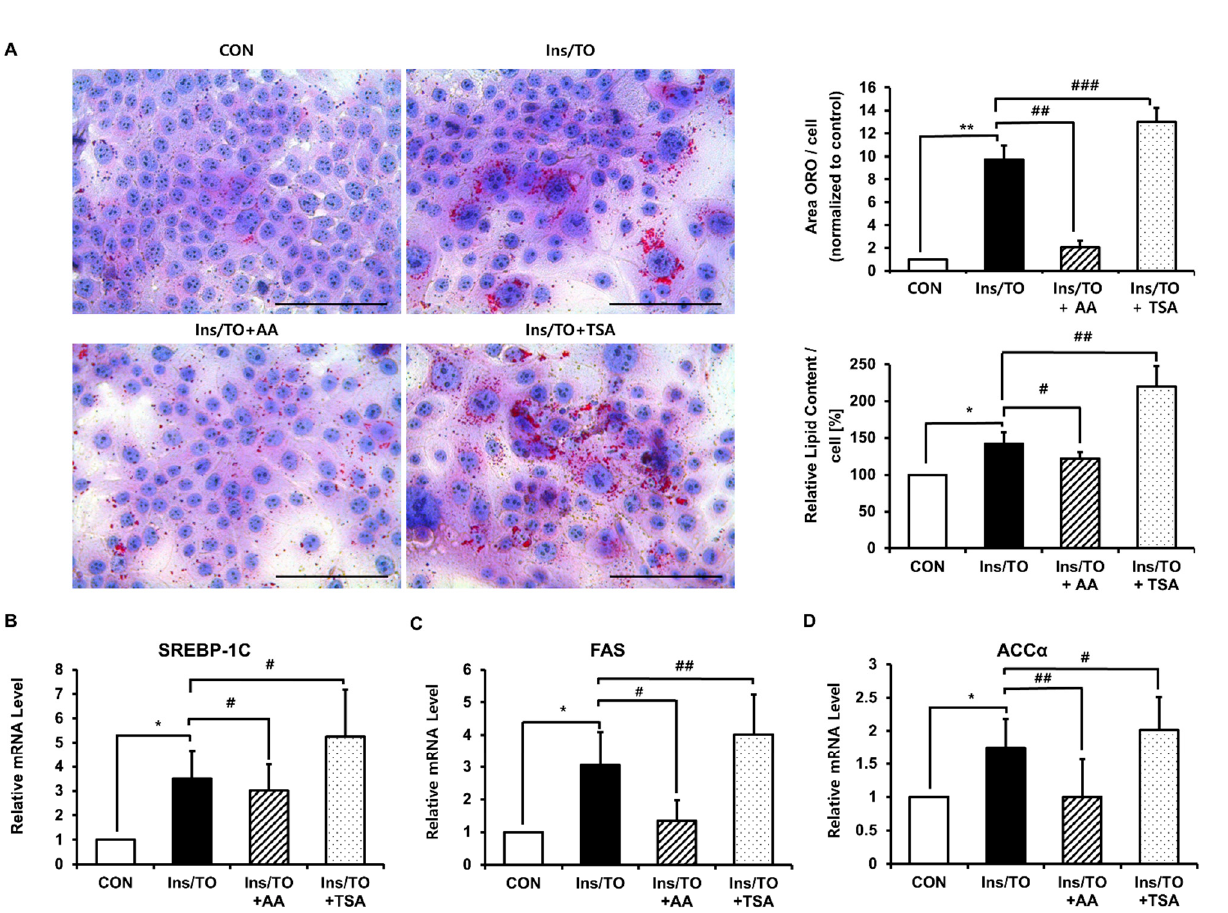
Figure 2. The p300 histone acetyltransferase (HAT) inhibitor anacardic acid (AA) inhibited lipogenesis through SREBP1 induction, whereas the histone deacetylase (HDAC) inhibitor trichostatin A (TSA) stimulated it. SZ95 cells were treated with 12.5 µM AA or 0.2 µM TSA in addition to insulin and liver X receptor (LXR) agonist TO901317 treatment (Ins/TO) for 48 h or 72 h. ( A ) After 72 h, Oil Red O staining was performed to analyze the amount of lipid droplets (left). Scale bar = 100 µm. Quantitative analysis of Oil Red O was performed using the Image J software. After Oil Red O staining, the lipid content was eluted into isopropanol, and the optical density at 500 nm was determined using a microplate reader. Values represent the mean ± SD from three independent experiments. * p < 0.05, ** p < 0.01 vs. control; # p < 0.05, ## p < 0.01, ### p < 0.001 vs. SZ95 cells treated with Ins/TO. ( B – D ) The expression of sterol regulatory element binding protein 1c (SREBP- 1c), FAS, and ACC α mRNA was quantified by real-time PCR 48 h after AA or TSA treatment and normalized to the respective 36B4 as a control. Values represent the mean ± SD from three independent experiments. * p < 0.05 vs. control; # p < 0.05, ## p < 0.01 vs. SZ95 cells treated with Ins/TO. ( E ) SREBP1 protein expression was measured 48 h after treatment by Western blotting. Bar graphs show densitometric quantitation of SREBP1 as ratios to α -Tubulin, which was used as the loading control. Data represent the mean ± SD of four independent experiments ( n = 4). * p < 0.05 vs. control; # p < 0.05, ### p < 0.001 vs. sebocytes treated with Ins/TO.